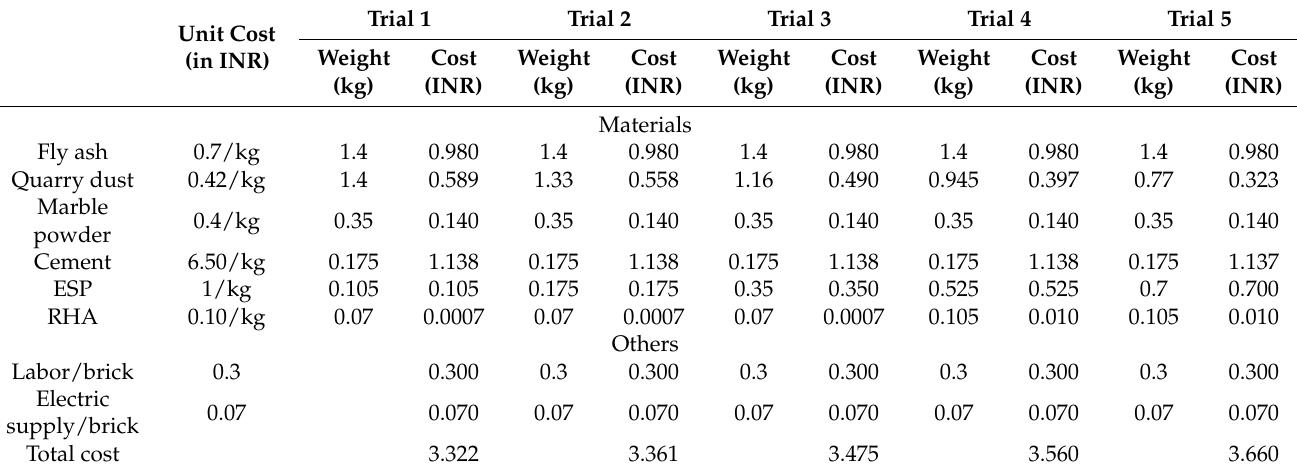
Table 4. Cost for production of bricks in each trial.